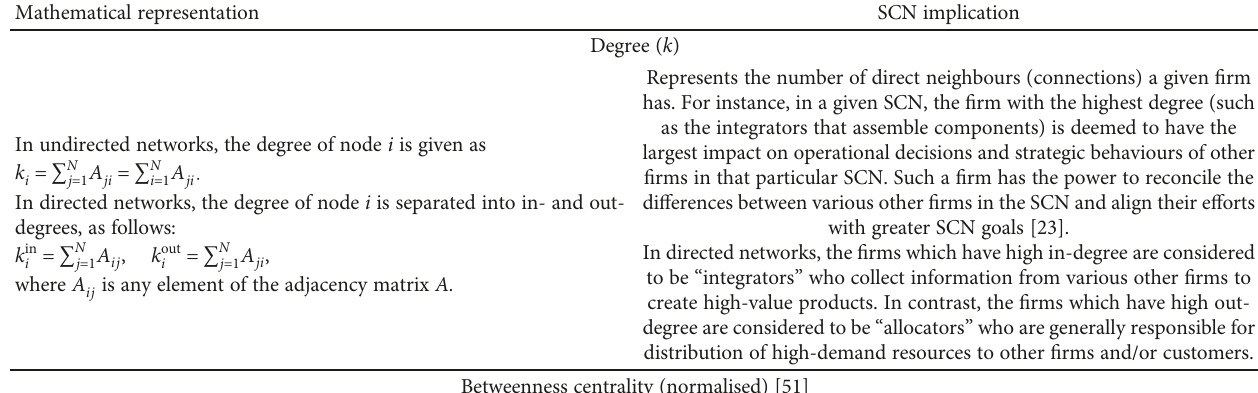
Table 6: Node-level metrics used and their SCN